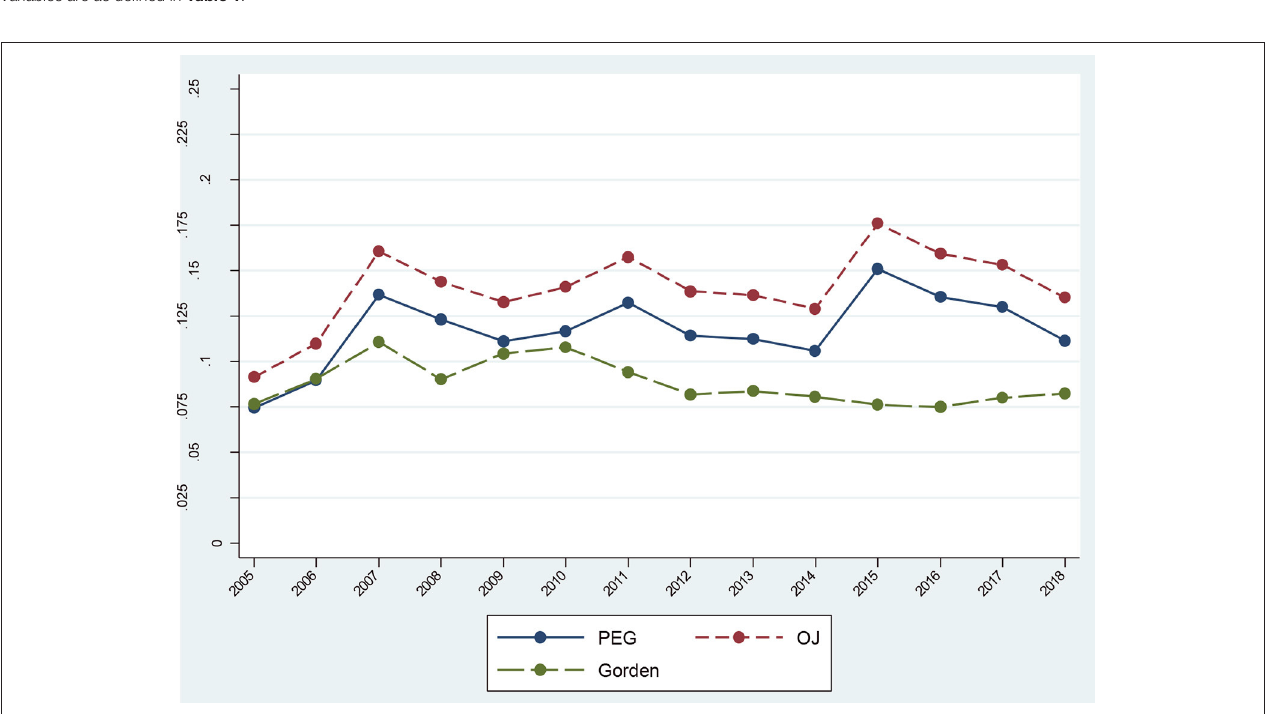
FIGURE 1 | Change trend of equity cost from 2005 to